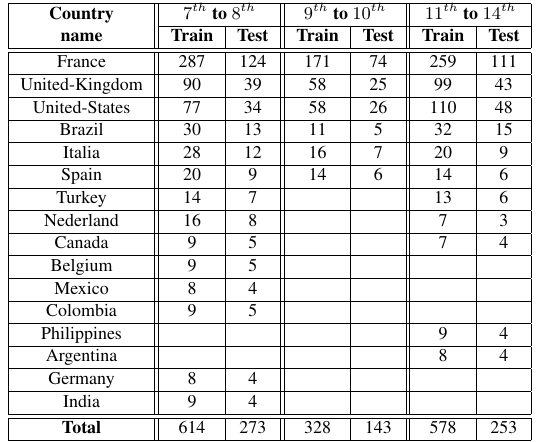
Table 1: Number of tweets for each period of January